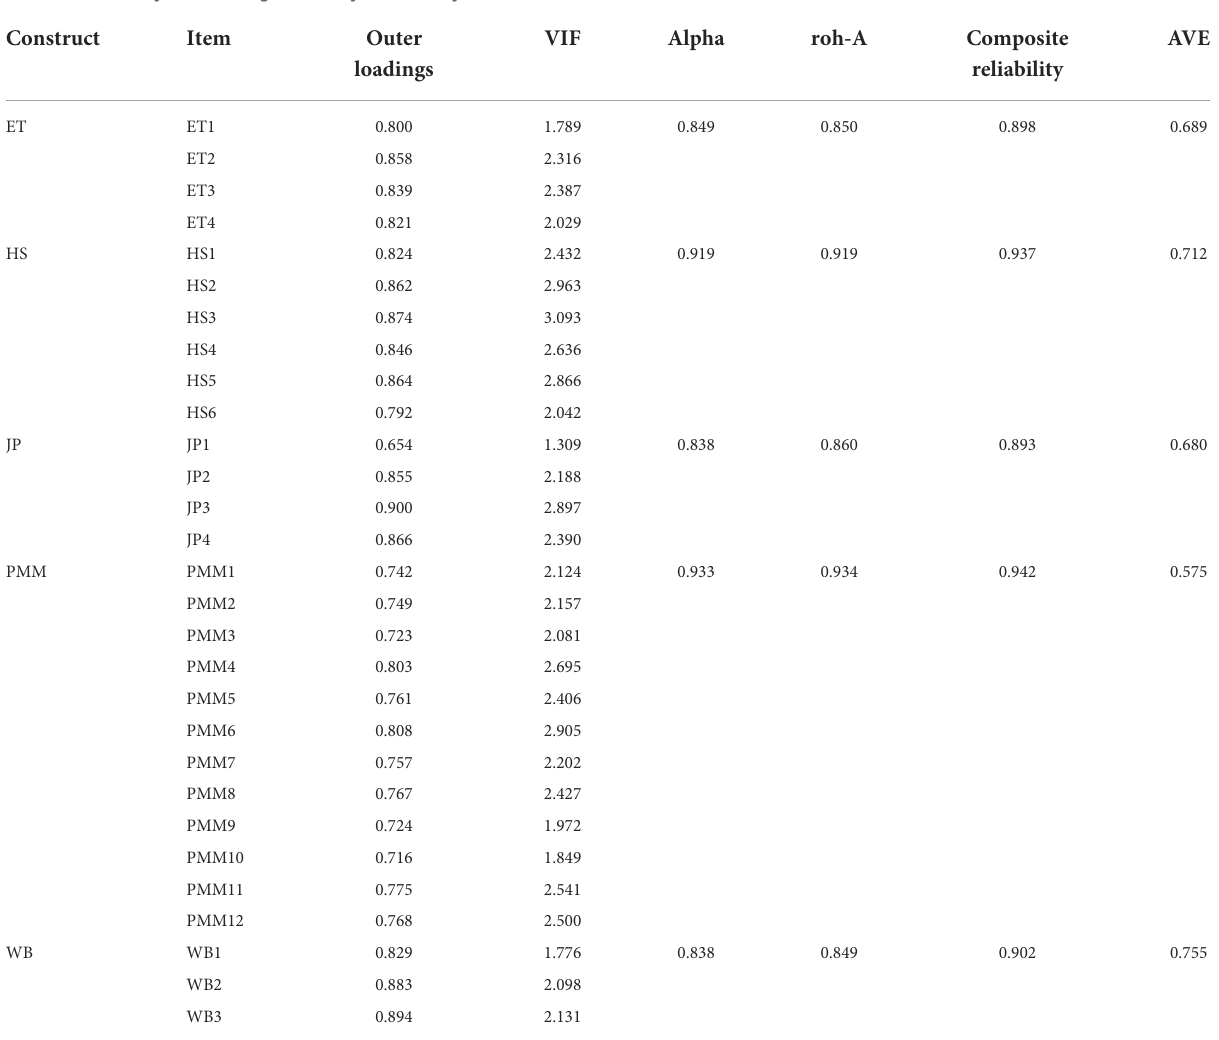
TABLE 1 Reliability and convergent validity of the study constructs.